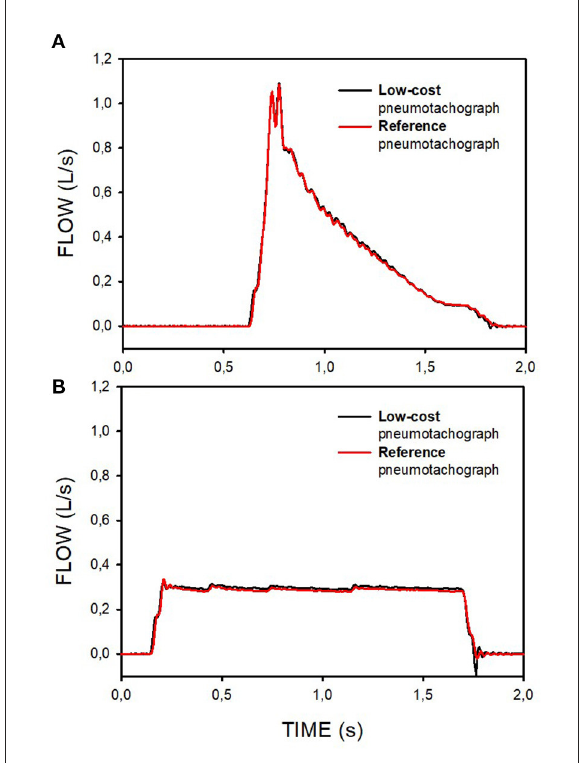
FIGURE5 Examples of the flow signals during pressure-controlled (A) and volume-controlled (B) mechanical ventilation simultaneously measured by a reference pneumotachograph and by the pneumotachograph constructed and calibrated by the low-cost procedures.